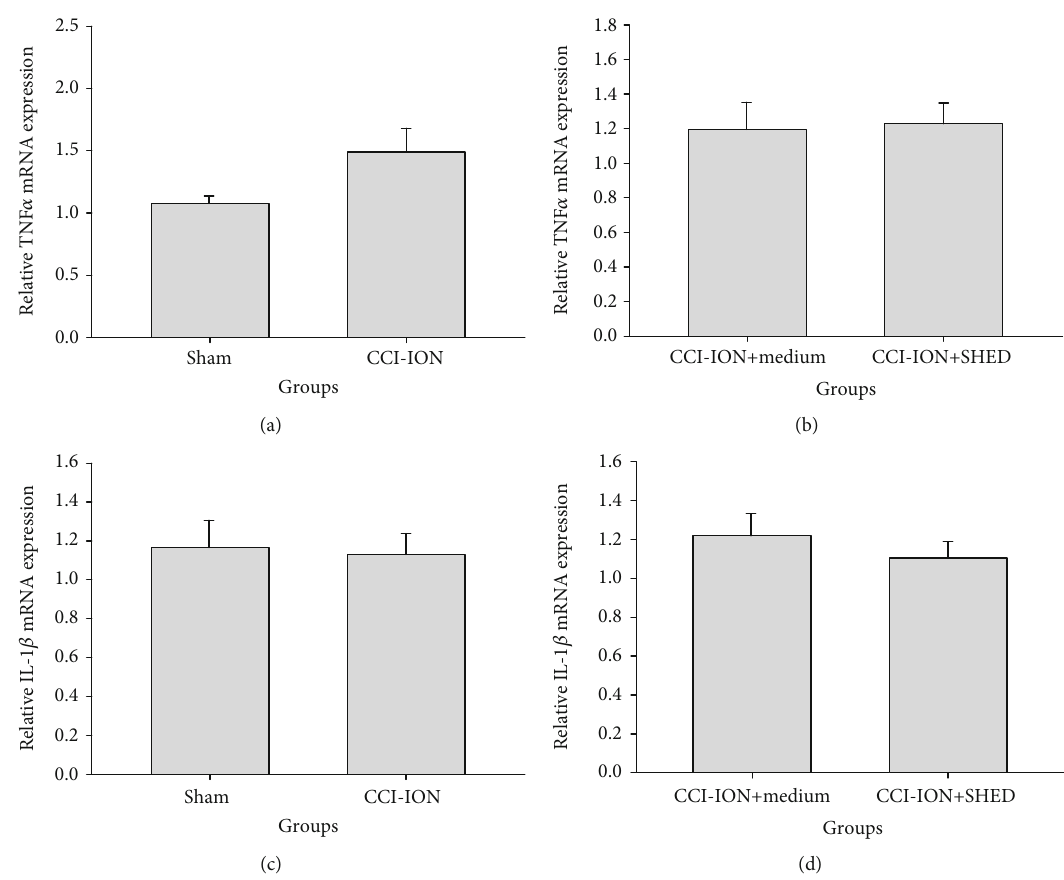
Figure 6: Local SHED transplantation reduces TNF- α and IL-1 β mRNA levels in the trigeminal nerve 56 days after transplantation. mRNA levels of TNF- α (a) and IL-1 β (c) in the injured trigeminal nerve measured 56 days after CCI-ION. mRNA levels of TNF- α (b) and IL-1 β (d) in the injured trigeminal nerve measured 56 days after local SHED transplantation ( 1 × 10 5 cells, 0.2mL). ∗ p < 0 : 05 vs. sham (a, c), ∗ p < 0 : 05 vs. medium (b, d). All data are expressed as the mean ± SEM ( n = 6 rats in each